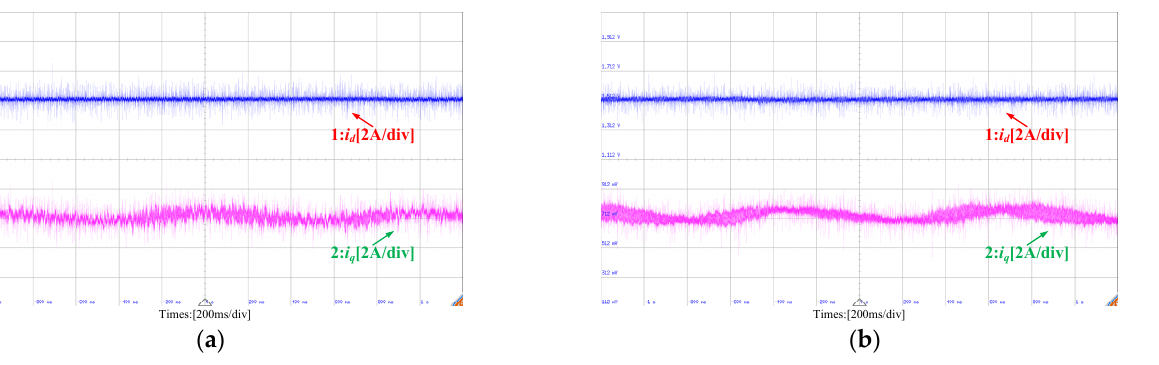
Figure 11. Experimental waveforms: ( a ) three-phase inverter bridge ( 1:𝑉 (cid:3005)(cid:3020) [200 V/div], 2: 𝐼 [5 A/div], 3: 𝑉 (cid:3008)(cid:3020) [10 V/div]); ( b ) primary side of the main transformer ( 1:𝑉 [200 V/div], 2:𝐼 [5 A/div]); ( c ) auxiliary switch ( 1: 𝑉 (cid:3005)(cid:3020) [100 V/div], 2: 𝐼 [10 A/div], 3: 𝑉 (cid:3008)(cid:3020) [10 V/div]); ( d ) auxiliary transformer ( 1: 𝑉 [100 V/div], 2:𝐼 [5 A/div]).